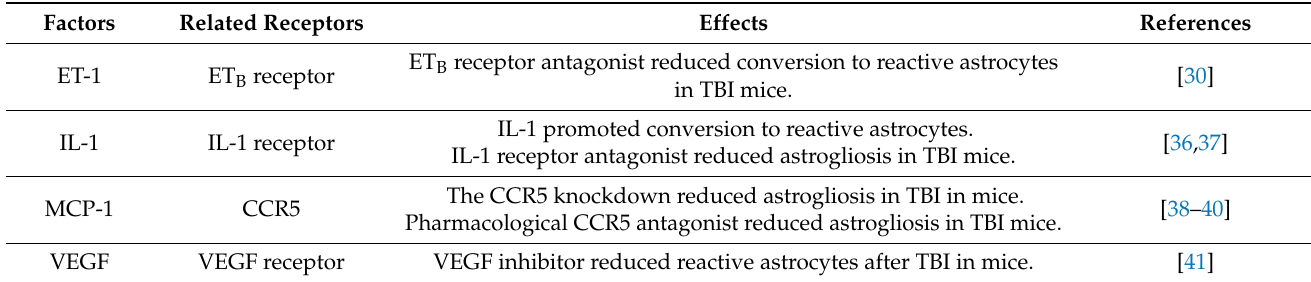
Table 1. Summary of the endogenous bioactive regulators for